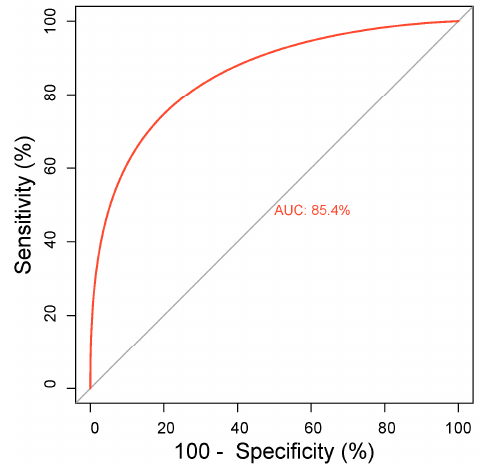
Figure 20. ROC Curve of AlexNet Model.